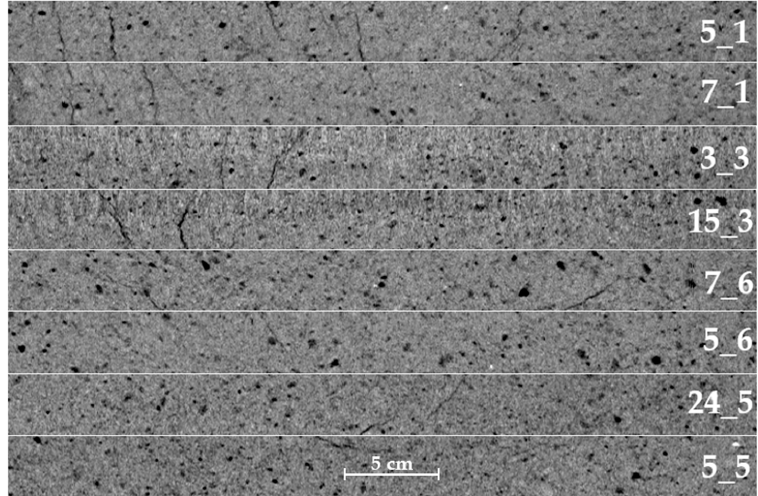
Figure 9. X-ray images showing the distribution of cracks and pores in selected corridors.